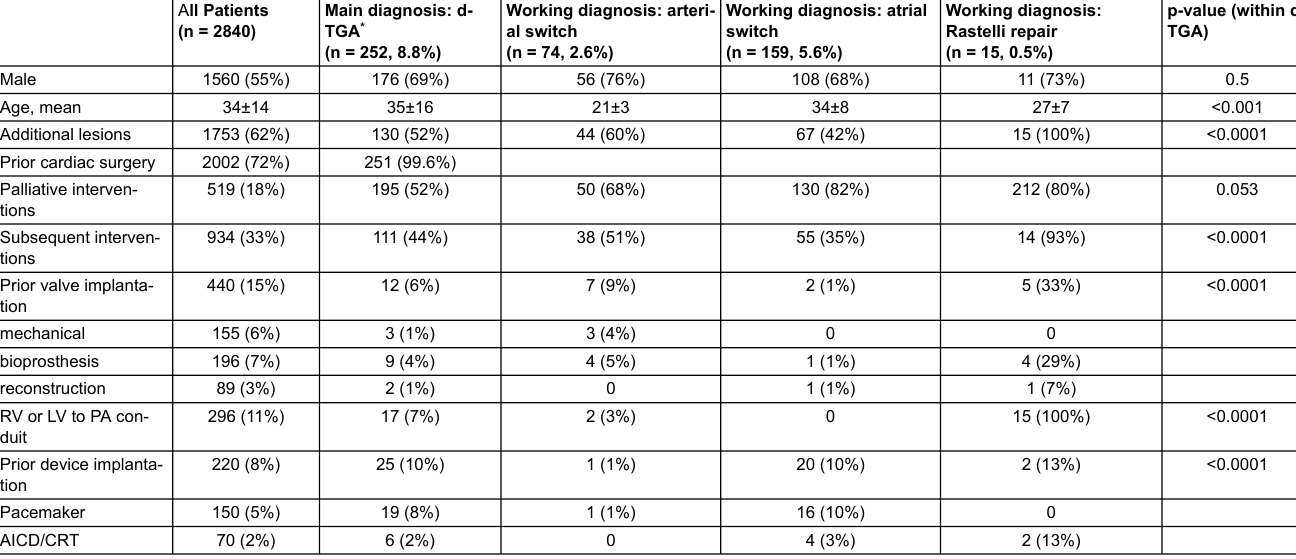
Table 4: Stratification of baseline characteristics for transposition of the great arteries, according to working diagnosis. A ll Patients (n =